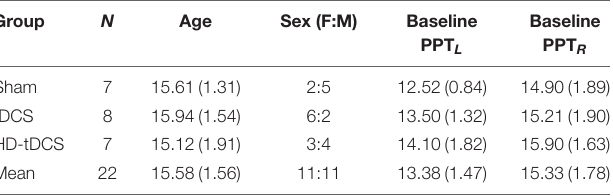
TABLE 1 | Demographics and mean (SD) baseline PPT